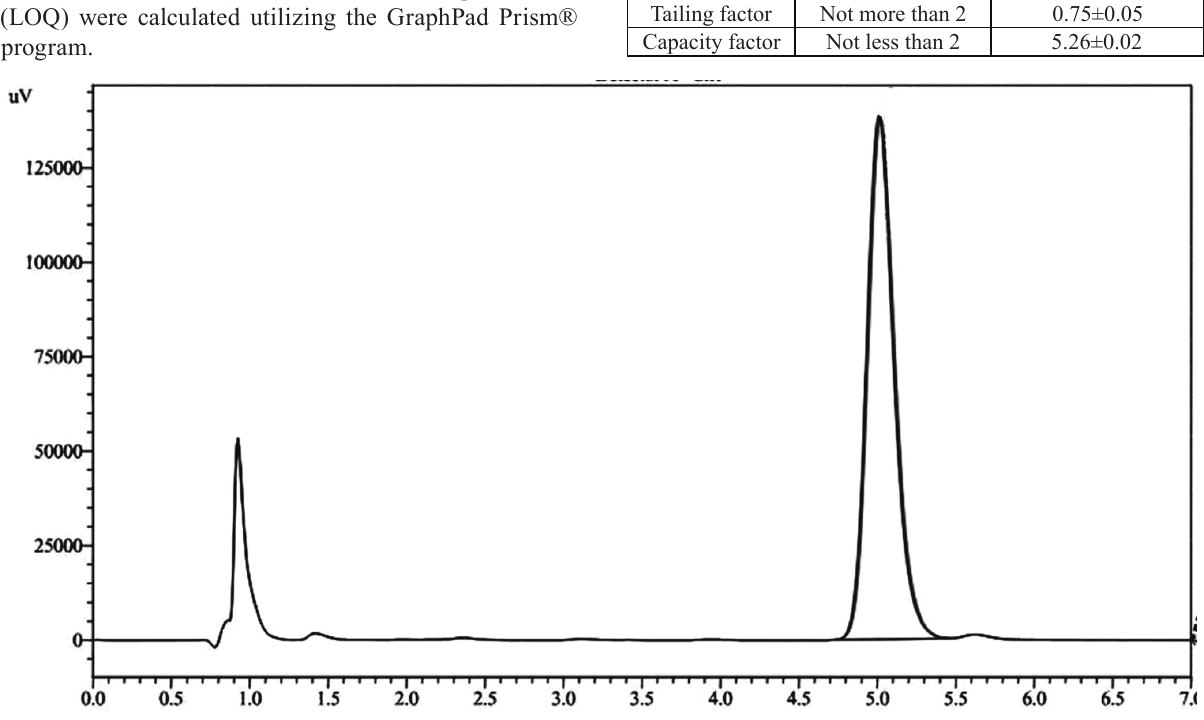
Fig. 2. HPLC spectrum of azilsartan